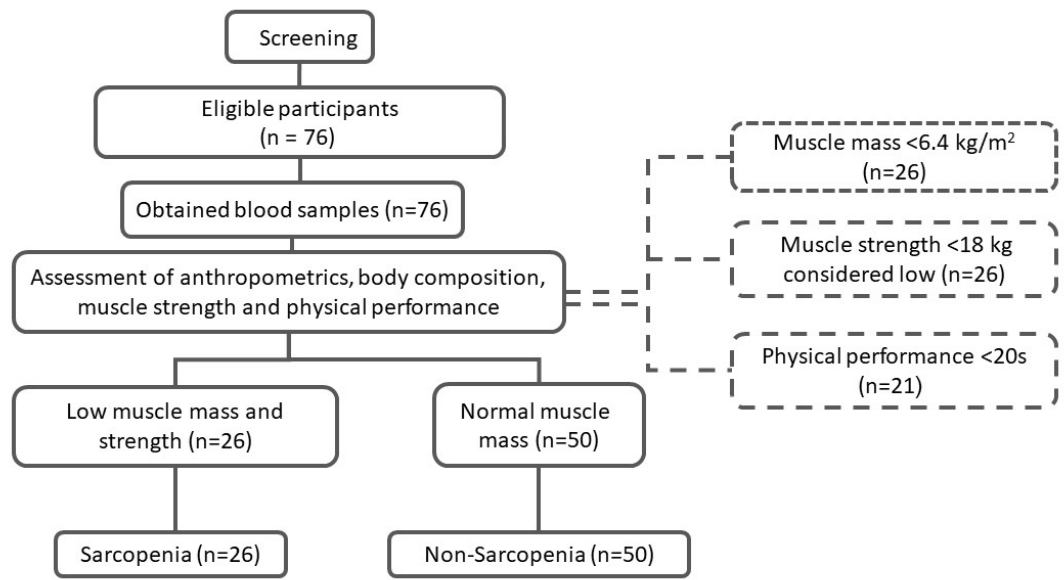
Figure 1. Screening process and enrolment of study participants.